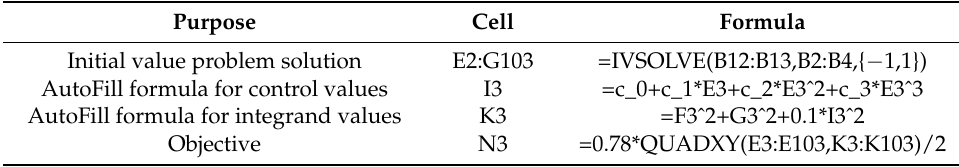
Table 2. Formula definitions used for solving optimal control problem